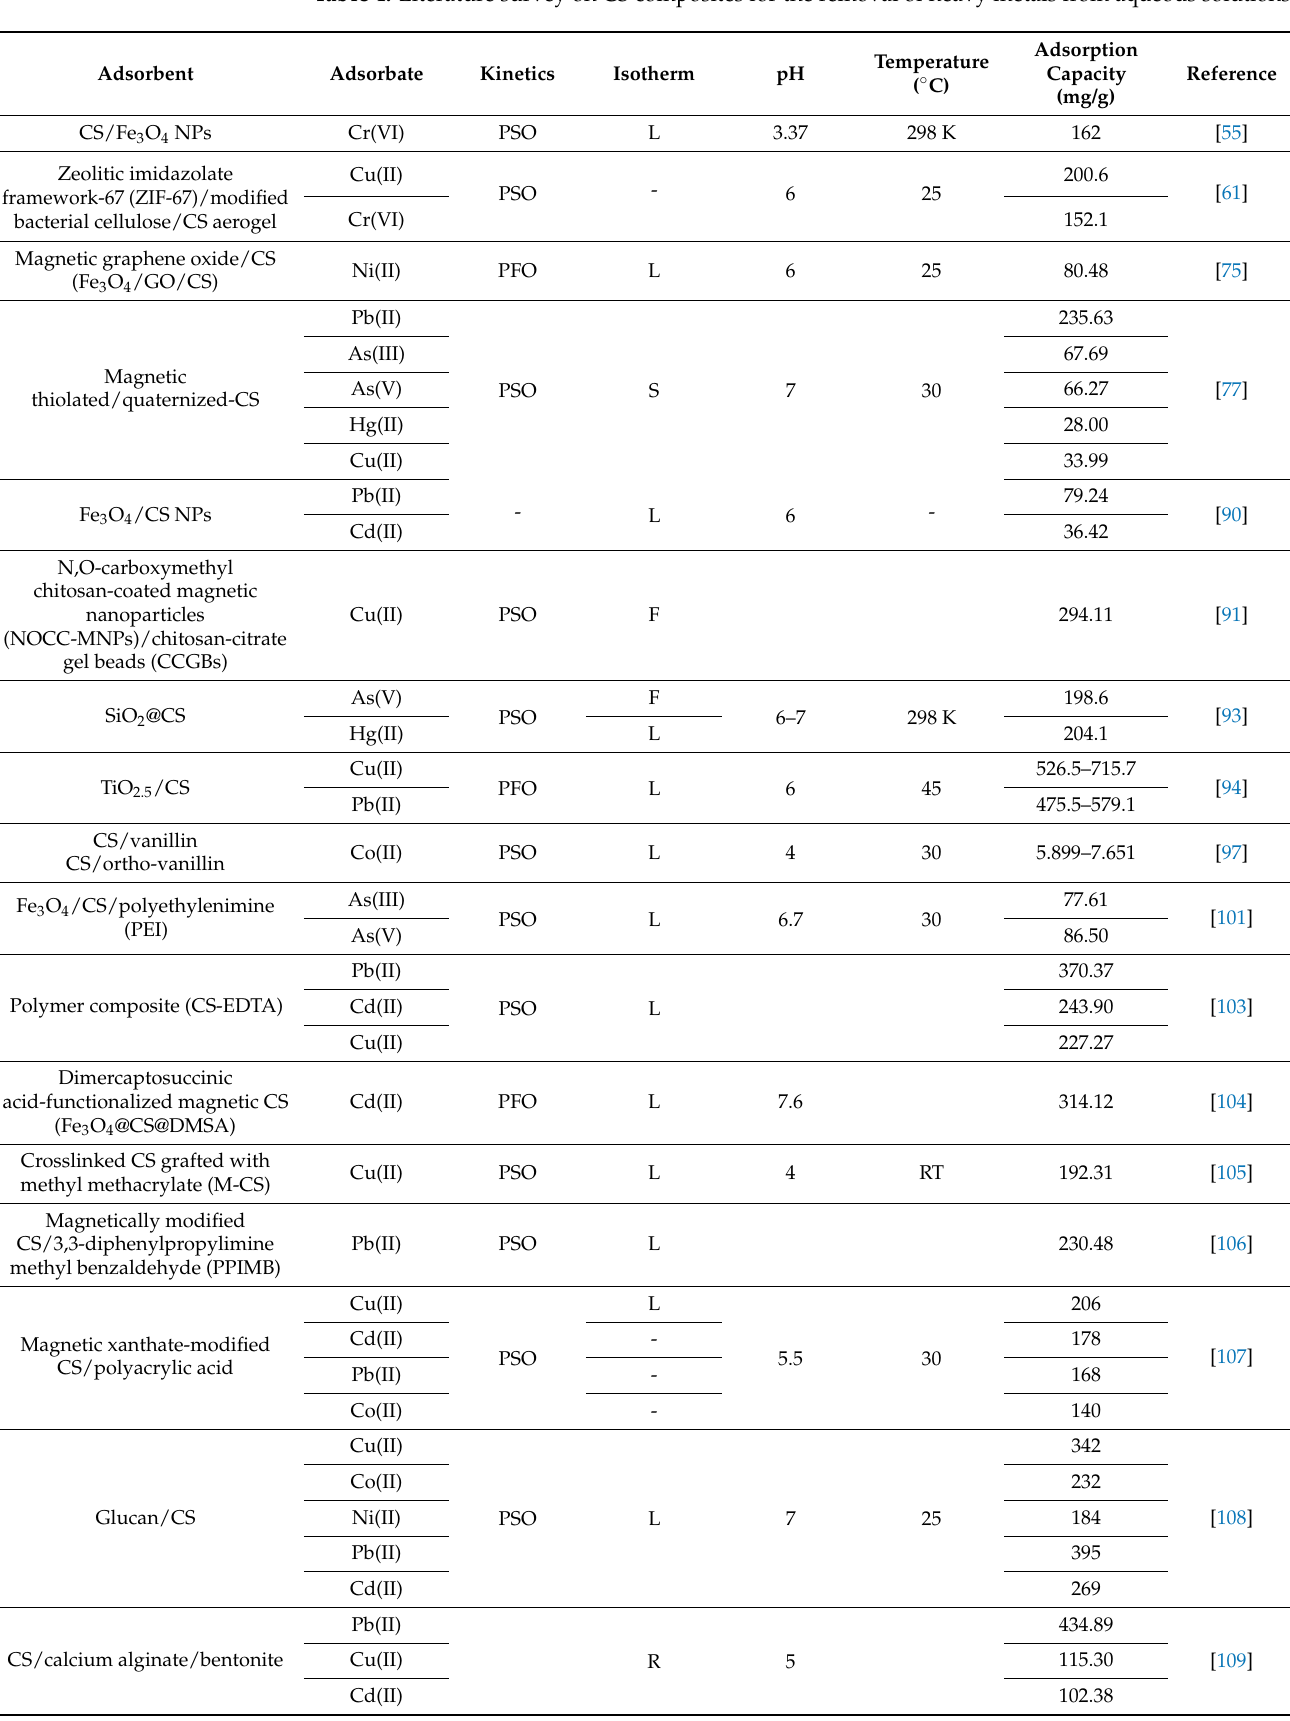
Table 4. Literature survey on CS composites for the removal of heavy metals from aqueous